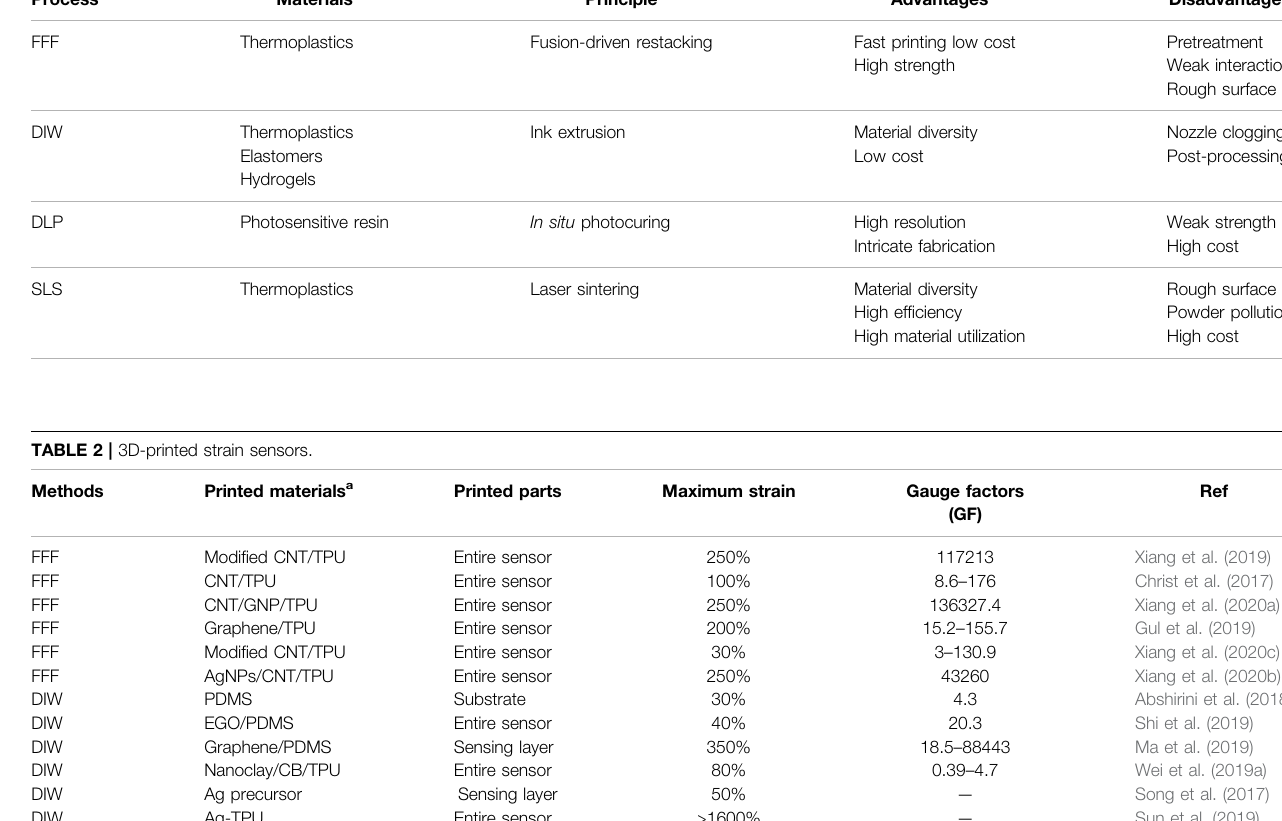
TABLE 1 | The principle and characteristics of 3D printing. Process